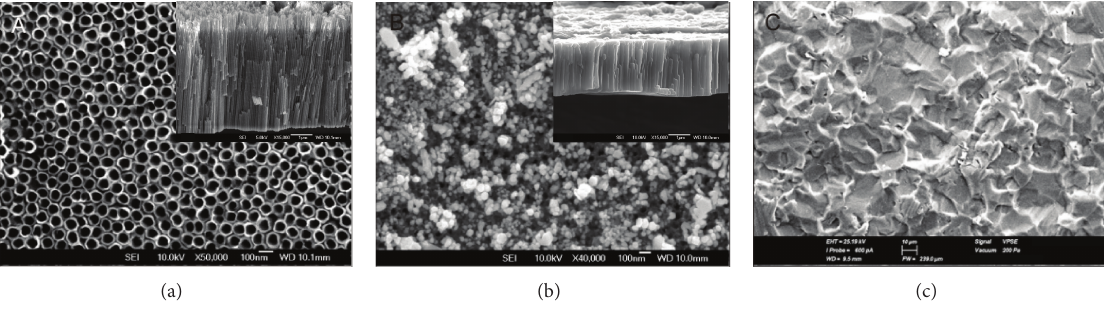
Figure 1: (a) Top-view FESEM micrograph of the surface of Group TiO 2 displaying as-annealed TiO 2 nanotubes (bar = 100nm). Inset: side view of the as-annealed TiO 2 nanotubes (bar = 1 𝜇 m). (b) Top-view FESEM micrograph of the surface of Group Ag displaying as-annealed Ag doped TiO 2 nanotubes (bar = 100nm). Inset: side view of the as-annealed Ag doped TiO 2 nanotubes (bar = 1 𝜇 m). (c) Top-view SEM micrograph of the surface of Group Ti displaying cpTi sheet (bar = 10 𝜇 m).